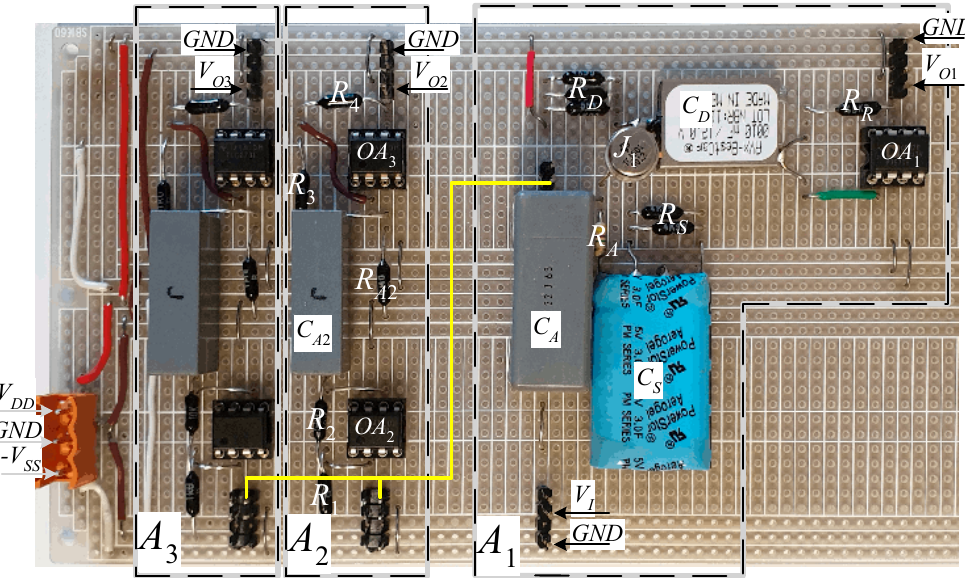
Figure 5. Top view of the implementation of the circuit in Figure 4. All components of amplifiers A 1 and A 2 are labeled with the same names used in Figure 4. The yellow path shows the connection that needs to be made to connect the gate of the JFET to the inputs of A 2 and A 3 .